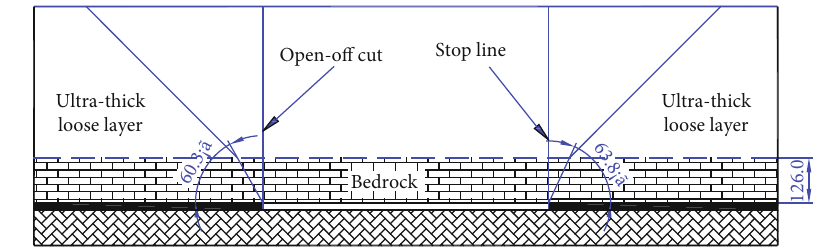
Figure 2: Schematic diagram of boundary angle.